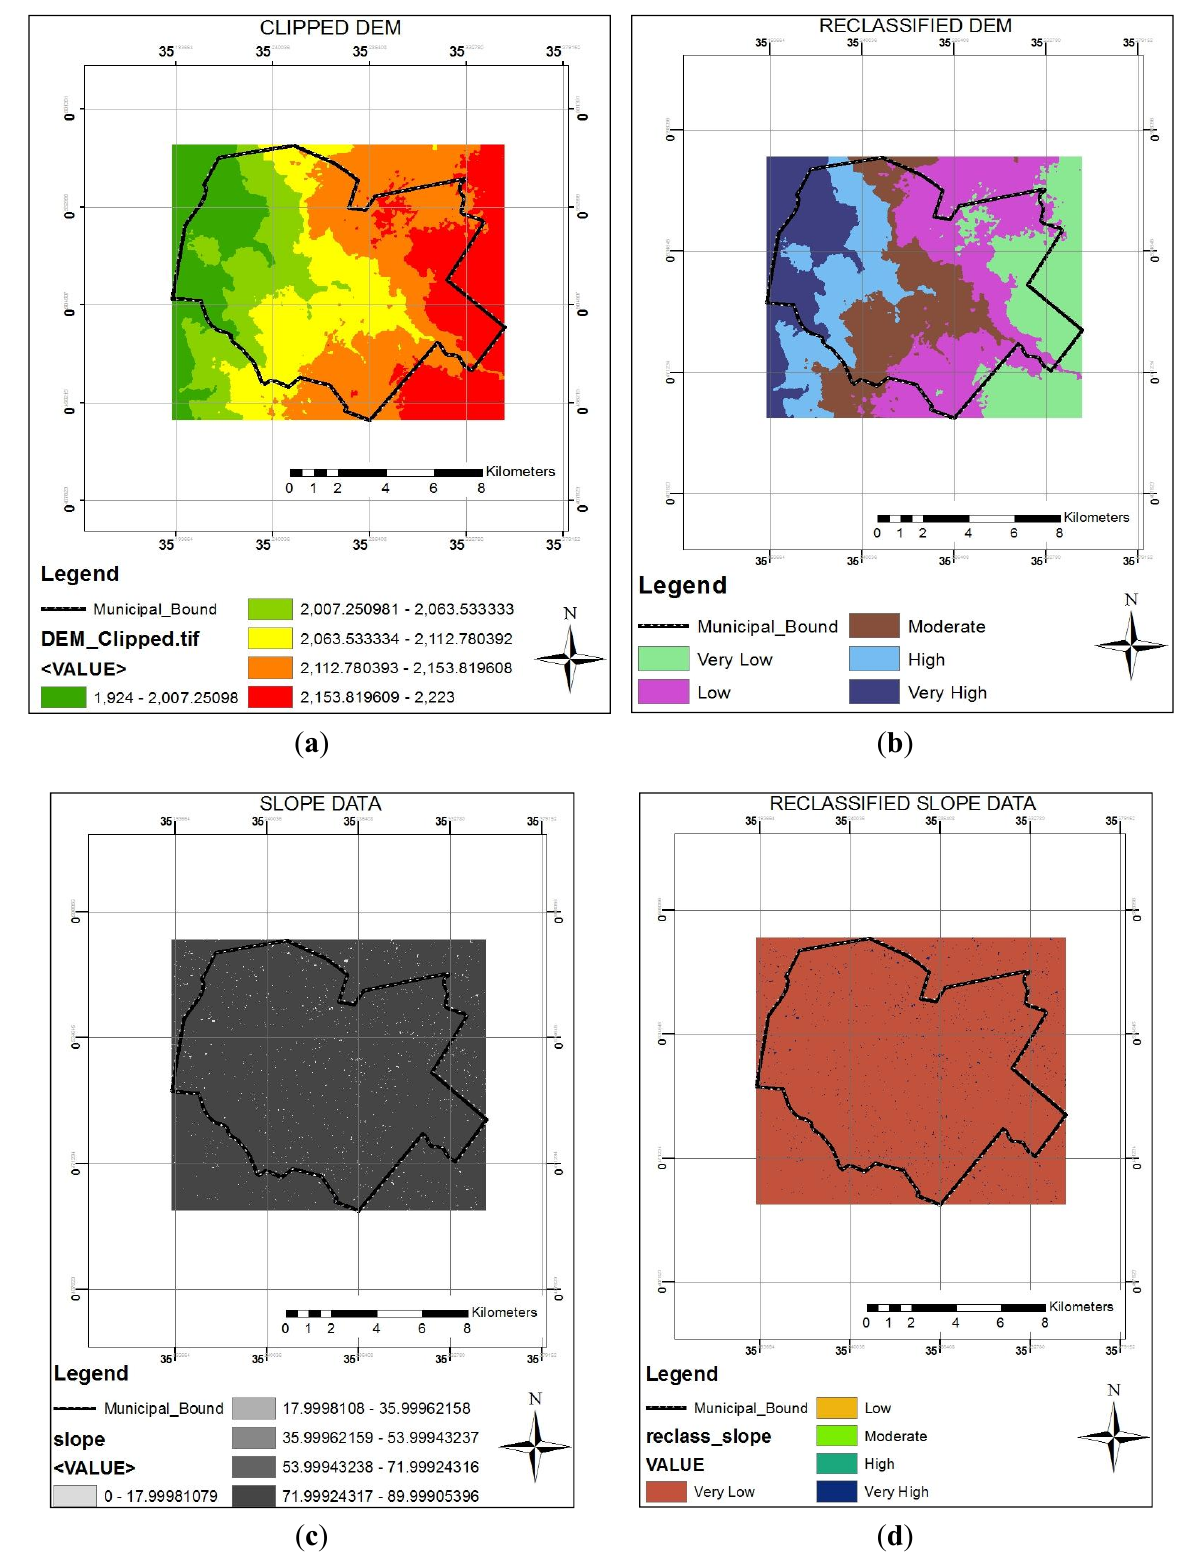
while ( b ) and ( d ) reclassified elevation and slope